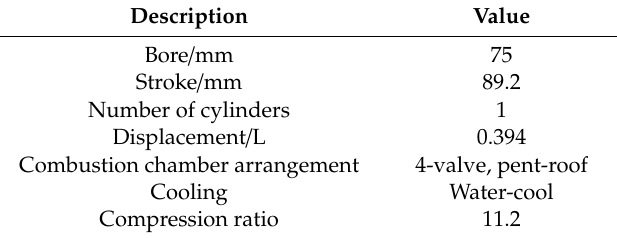
Figure 1. Configuration of the full-visible piston window. Table 1. Engine specifications.